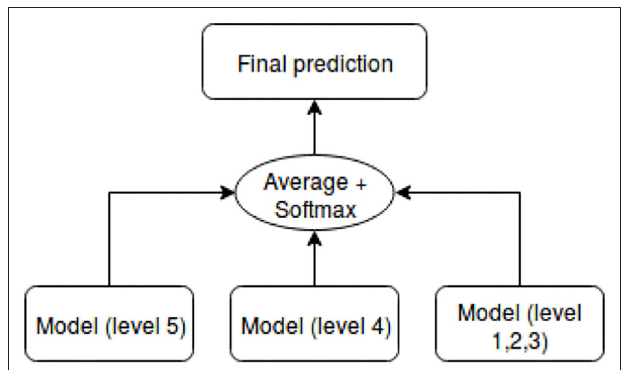
FIGURE 6 | Final model for predicting socio-moral reasoning skill